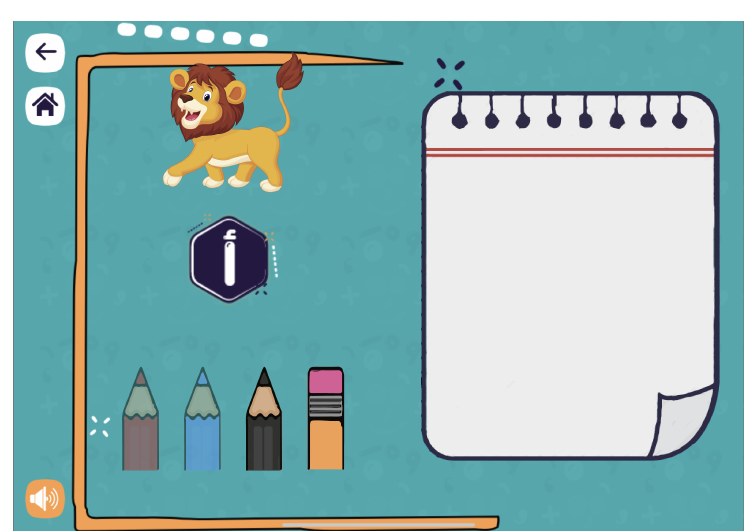
Figure 4. The writing board page